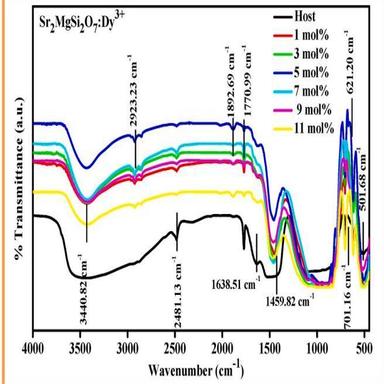
FTIR spectra for Sr2MgSi2O7:Dy3þ NPs.